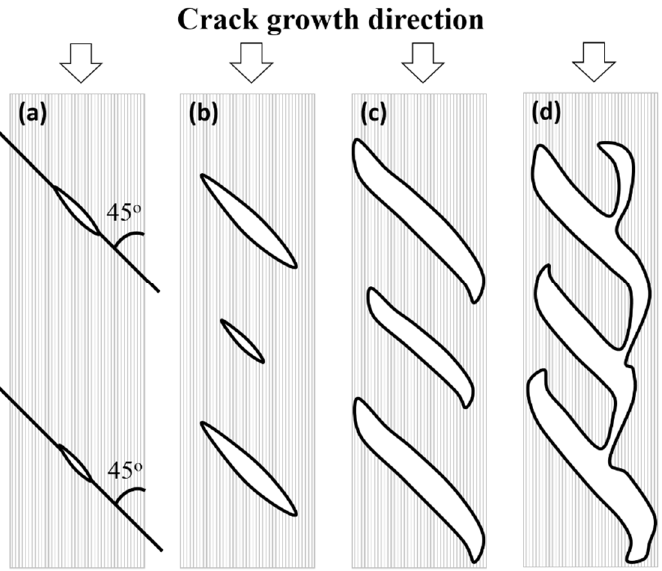
Figure 6. Schematic diagrams of crack formation in ENF specimens ( a ) micro-cracks ( b ) extension of micro-cracks and formation of a new crack ( c ) crack growth near shear band limit ( d ) coalescence of cracks [32].